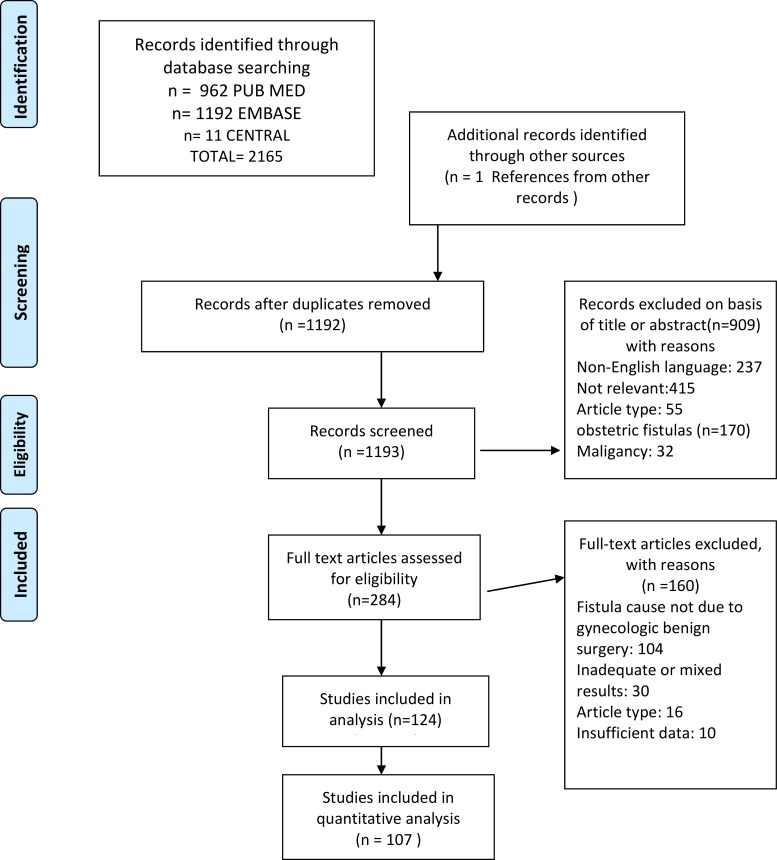
PRISMA Flow Chart.